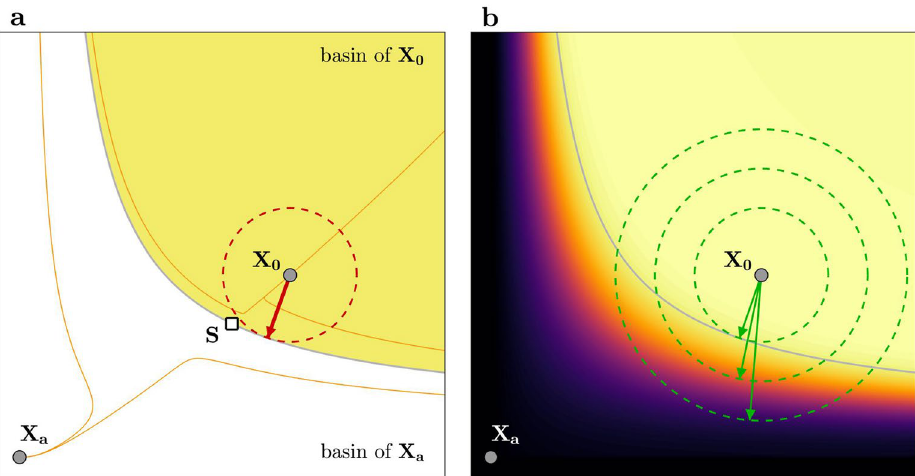
Figure 1. Representation of the Minimal Fatal Shock and the related search algorithm. ( a ) The MiFaS (red arrow) is the smallest perturbation to the desired state X 0 which puts the system outside the basin of X 0 and into the basin of an alternative attractor X a . ( b ) The search algorithm starts with a relatively large perturbation magnitude. The related subspace of allowed initial conditions is given by the largest circle and the direction of maximum amplification is displayed by the green arrow. As the magnitude of allowed perturbations is reduced, the direction of maximum amplification converges towards the MiFaS. Color coding marks the objective function (distance to the desired state after a short integration time) with dark colors displaying large values and bright colors small values. This figure was generated using MATLAB version R2020a (https ://www.mathw orks.